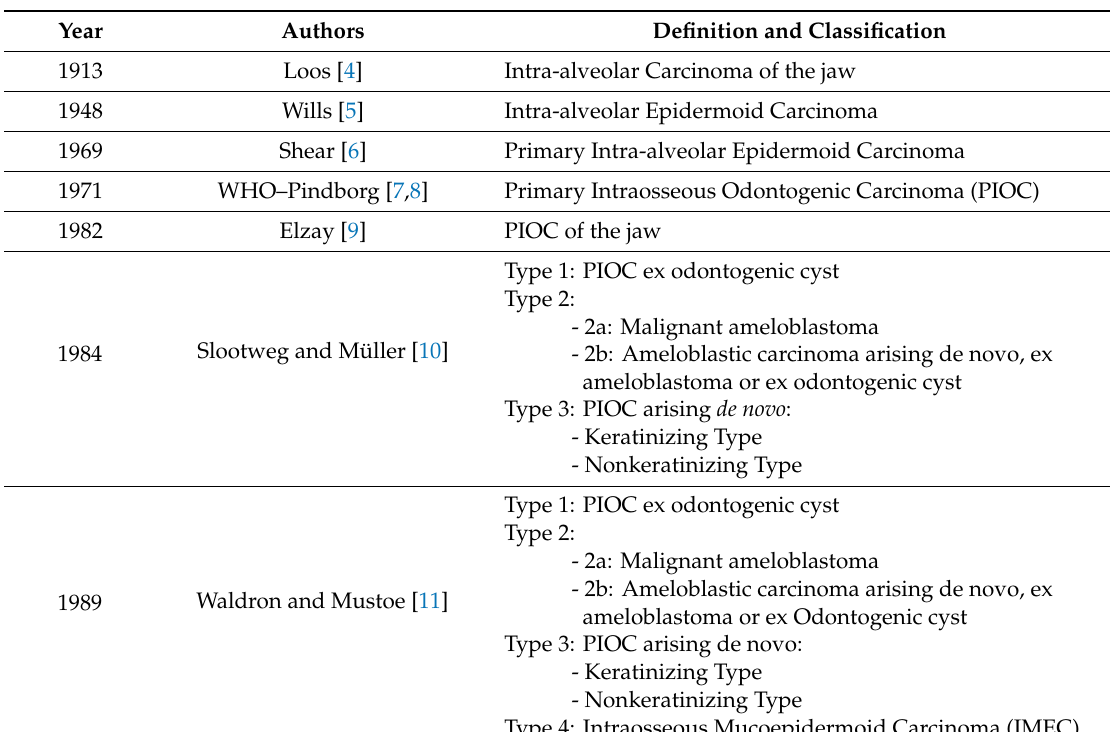
Table 1. Changes in the definition and classification of the PIOSCC over the years, with related